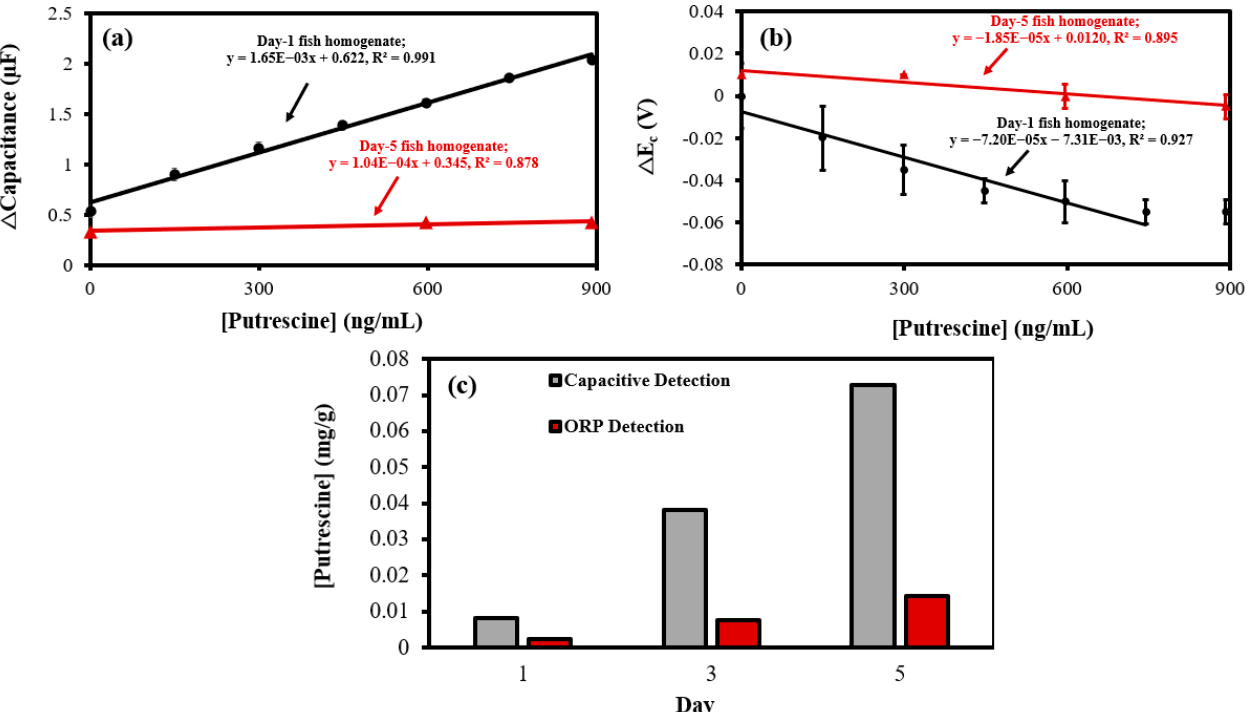
Figure 9. ( a ) Cathodic Δ capacitance; and ( b ) Δ E c vs. putrescine concentration standard addition (SA) calibration plots of 1-day and 5-day-old salmon fish analysis ( n = 3) using the MN redox sensor. ( c ) Putrescine concentrations calculated from cathodic Δ capacitance (Capacitive Detection) and Δ E c (ORP Detection) vs. putrescine concentration SA plots in salmon taken over a 5-day period.